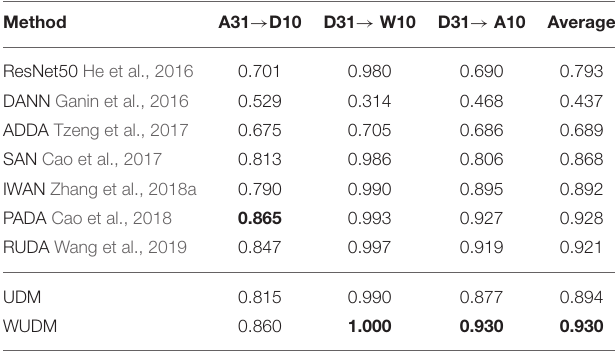
FIGURE 3 | t -SNE embeddings of the representations for Syn12 → Real6. The features are embedded into the same subspace and visualized within the same scope. (A) is the source representation with 12 classes. (B–D) are the adapted target representation with 6 classes. The embedding from WUDM consists of 6 disentangled clusters, while others tend to be more entangled or contains excessive number of clusters. TABLE 3 | Partial domain adaptation on